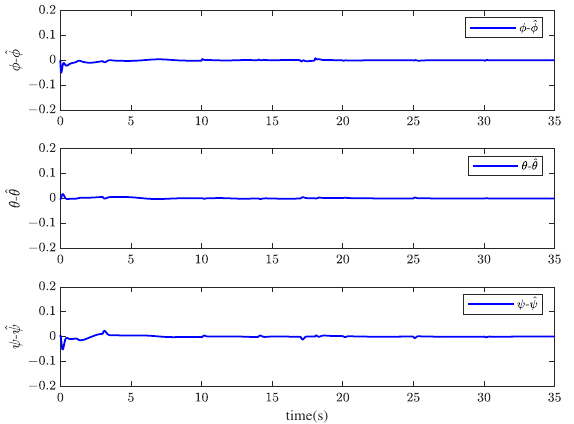
Figure 10. The roll angle φ , pitch angle θ , yaw angle ψ , and their estimation ˆ φ , ˆ θ , and ˆ ψ when z = 1 s.